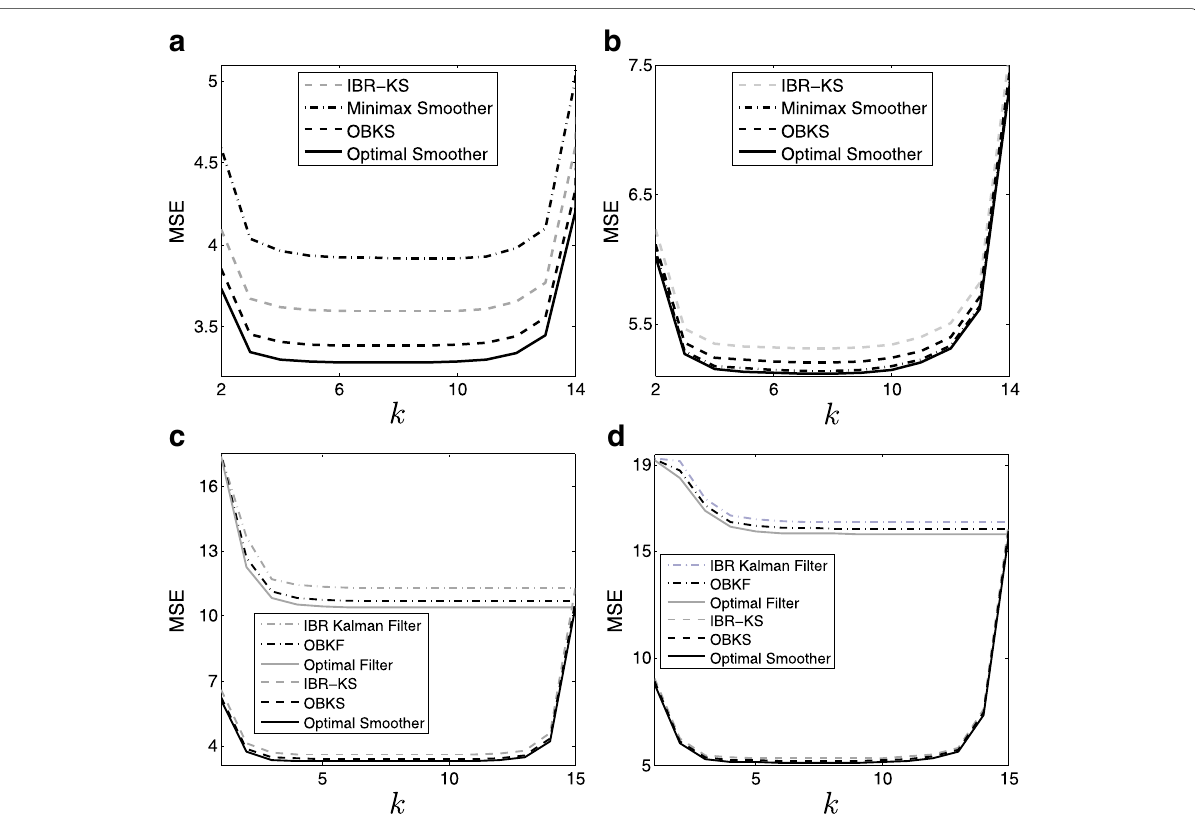
Fig. 7 Performance of different smoothing approaches when applied to specific state-space models for the target tracking example with unknown r and q . a MSE of different smoothers for θ 1 = 4.5 and θ 2 = 1. b MSE of different smoothers for θ 1 = 3.2 and θ 2 = 4. c MSE of different smoothers and filters for θ 1 = 4.5 and θ 2 = 1. d MSE of different smoothers and filters for θ 1 = 3.2 and θ 2 =